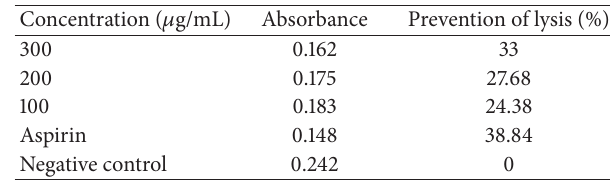
Table 3: Data representing absorbance and percentage prevention of